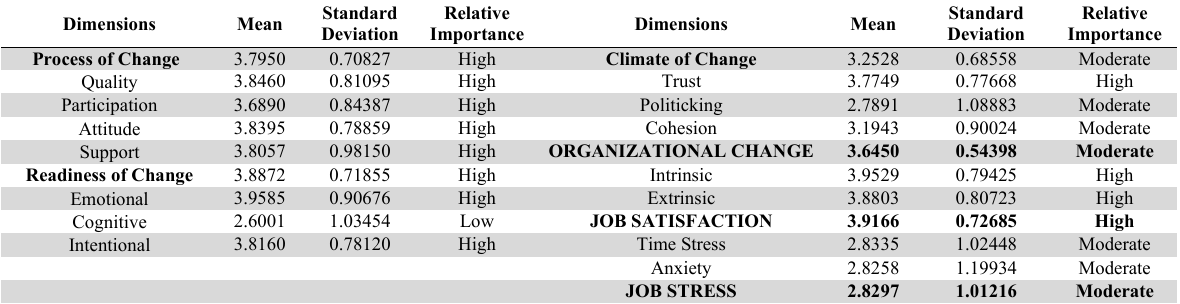
Mean and Standard Deviation Values Dimensions